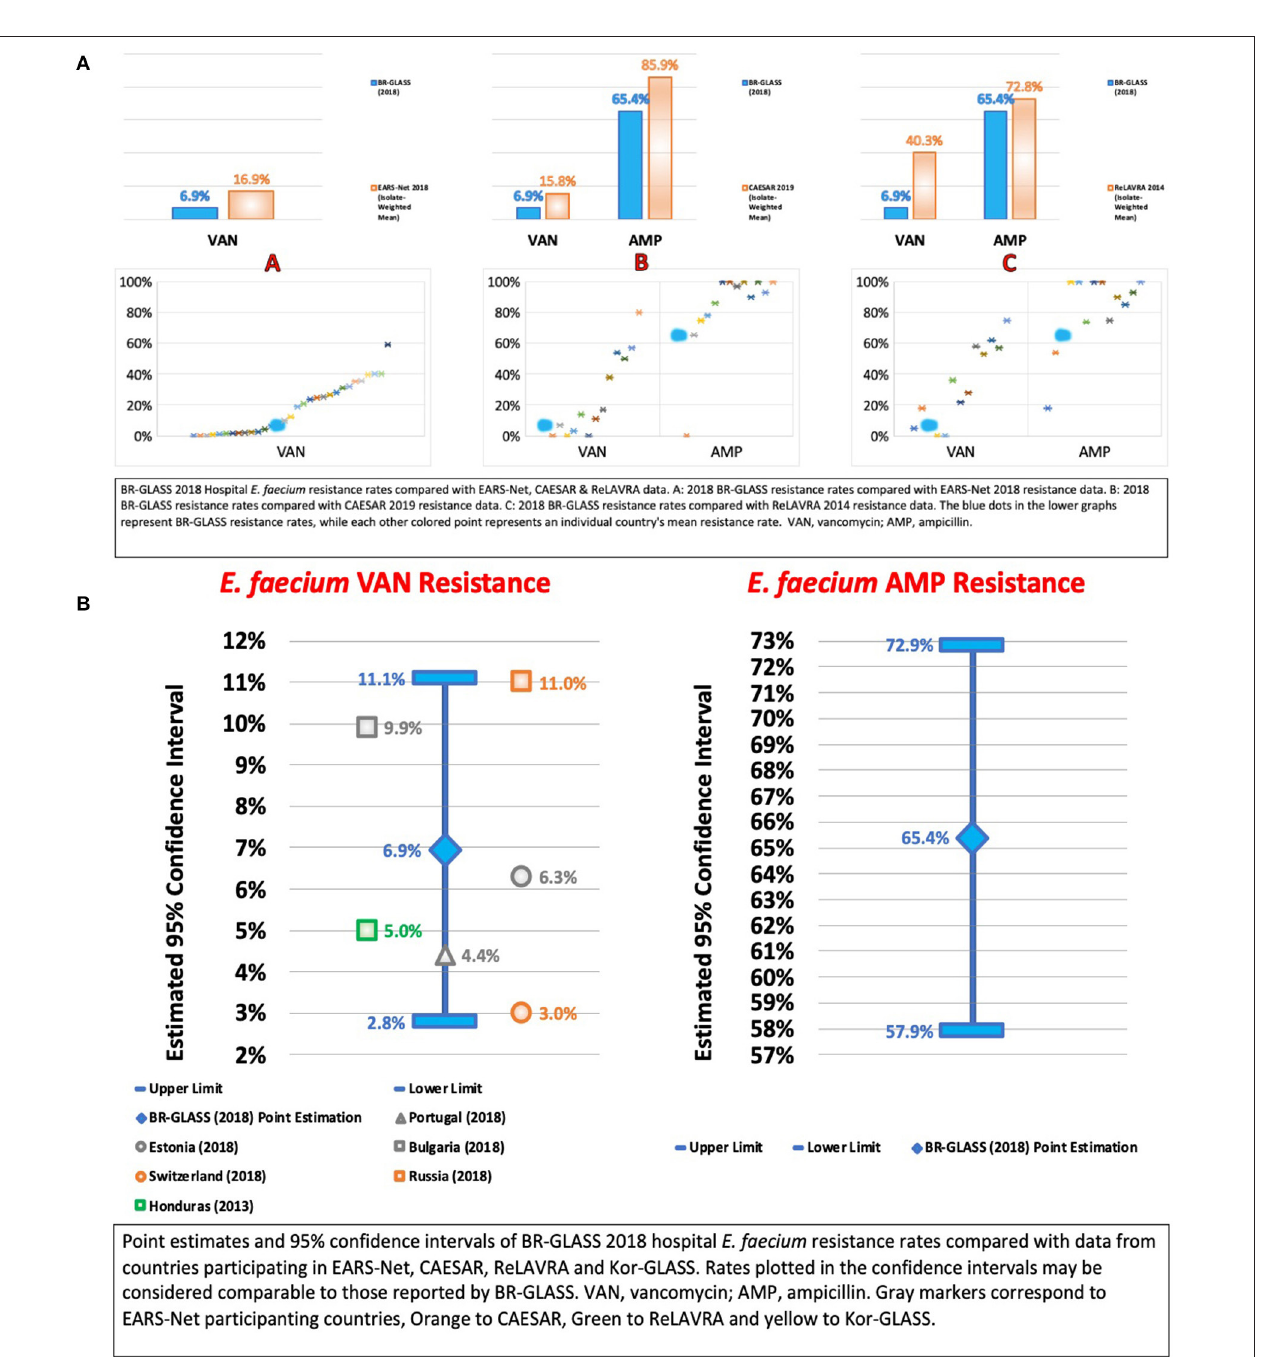
FIGURE 13 | (A) BR-GLASS 2018 Hospital E. faecium resistance rates compared with general EARS-Net, CAESAR, and ReLAVRA data. (B) BR-GLASS 2018 Hospital E. faecium estimated resistance rates with 95% confidence intervals and comparable rates reported in different countries.